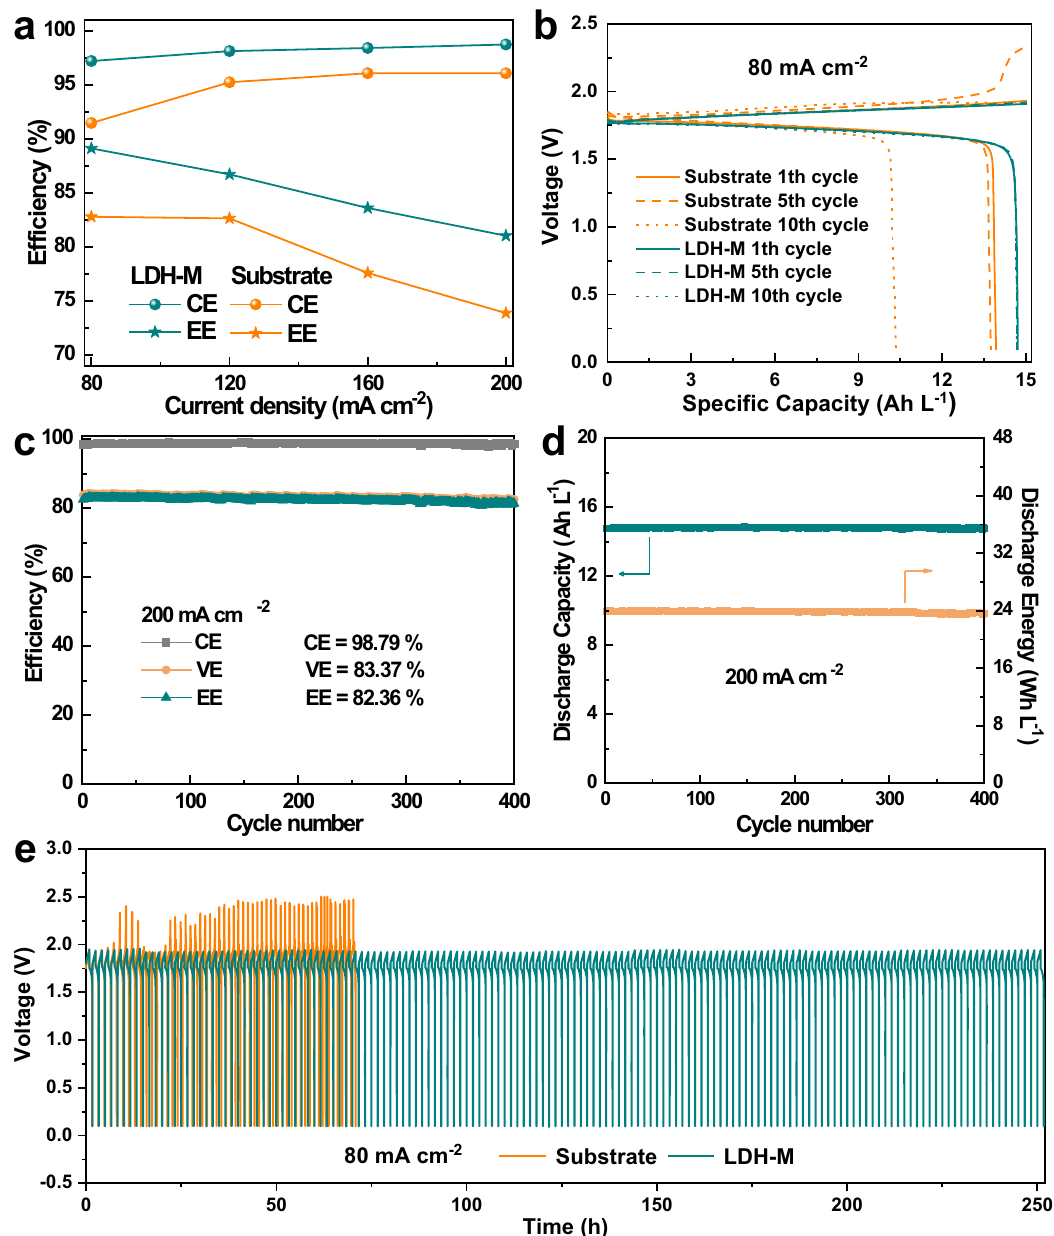
Fig. 6 Electrochemical performance of the AZIFB employing LDH-M and substrate. a Rate performance as the current density ranging from 80 to 200 mA cm − 2 . b The voltage pro fi les in the 1th, 5th, 10th cycles for AZIFB. c The cycling performance of AZIFB assembled with a LDH-M at 200 mA cm − 2 . d Corresponding discharge capacity and discharge energy for each cycle at 200 mA cm − 2 . e The voltage – time pro fi les at a current density of 80 mA cm − 2